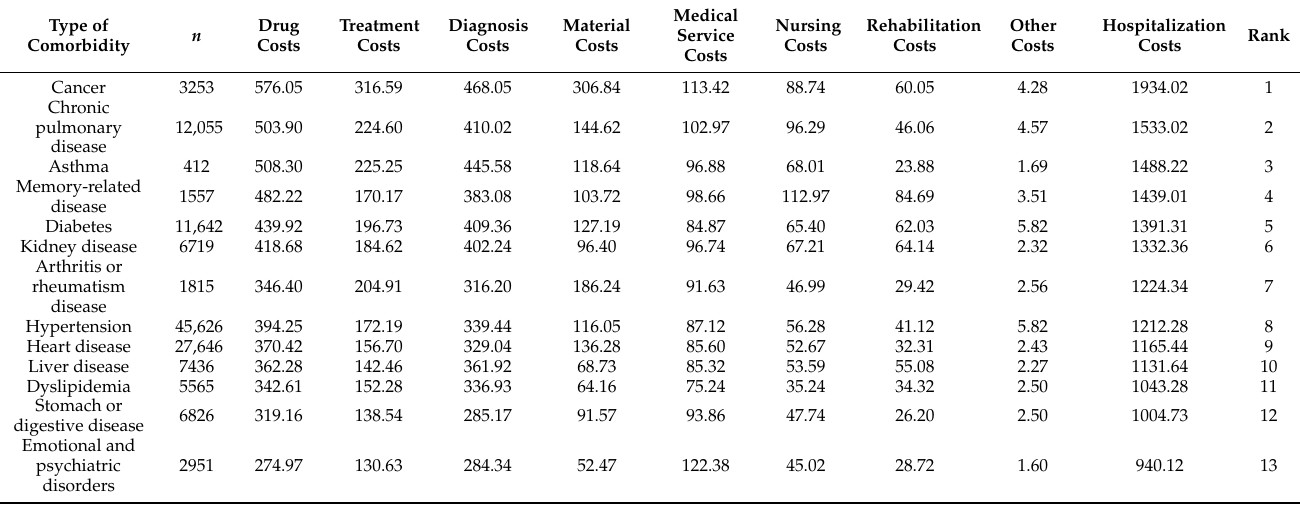
Table 3. The status of costs in different types of comorbidities for cerebral infarction patients (US